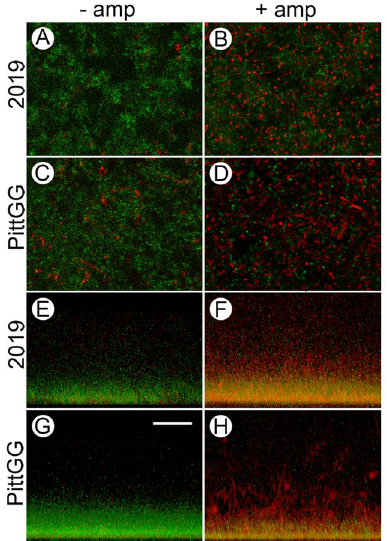
Figure 5. Sub-inhibitory concentrations of ampicillin result in an increase in dead NTHi bacteria in newly formed biofilms. Confocal laser scanning microscopy (cLSM) of biofilms formed by NTHi strains 2019 and PittGG in the absence ( 2 amp) and presence ( + amp) of sub-inhibitory concentrations of ampicillin were stained using the LIVE/DEAD viability assay. 2019 were exposed to 90 ng/mL ampicillin and PittGG to 170 ng/mL ampicillin. Live bacteria were colored green and dead bacteria red. From above, biofilms formed in the absence of ampicillin were mostly green (A & C), indicating living (or intact) NTHi bacteria. Clumps of bacteria in both biofilms stained red (A & C) indicating the presence of dead, or structurally compromised bacteria. Biofilms formed by 2019 (A) contained fewer aggregates of red bacteria than did PittGG (C) contained more. In the presence of ampicillin (B & D) the bacteria in the biofilms were mostly red, indicating a large number of dead bacteria. Green-stained bacteria were still present in both biofilms but appeared more aggregated in the presence of antibiotic (B & D). Large amounts of aggregated red bacteria were present in both biofilms, with the aggregates being larger in the PittGG biofilm (Fig. D). Z-stack projections of the biofilms (E–H) showed that all the biofilms were denser at the base of the biofilm, whether exposed to ampicillin or not. In the absence of ampicillin, 2019 (E) and PittGG (G) biofilms comprised green, or intact bacteria. In the presence of ampicillin